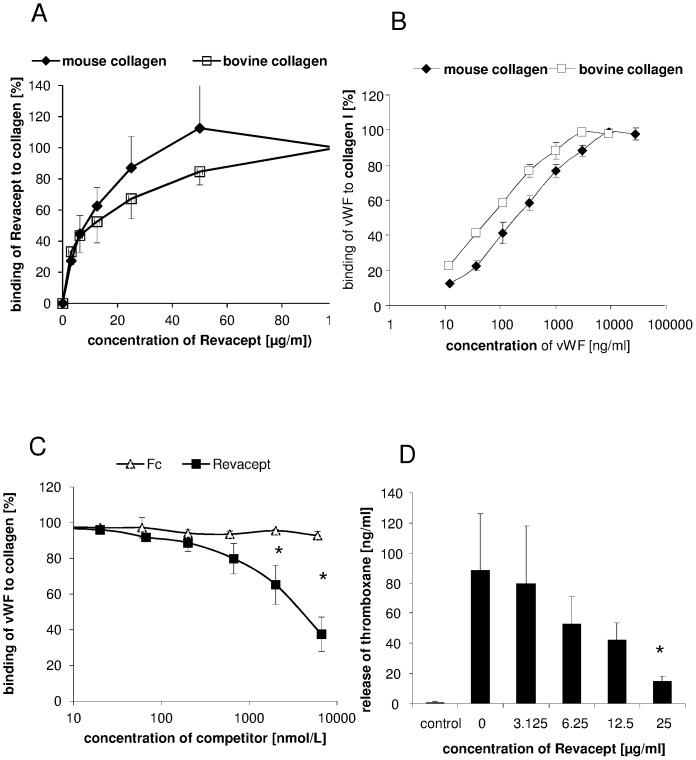
In vitro binding characteristics of Revacept.(A) Concentration-dependent binding of Revacept to immobilized mouse or bovine collagen on microtiter plates. (B) Increasing concentrations of von Willebrand factor (vWF) also bind to immobilized mouse or bovine collagen type I on microtiter plates. (C) Increasing amounts of Revacept lead to a competition with vWF for collagen binding. In contrast, Fc only did not show any inhibitory effect when used in equimolar amounts. Mean ± SEM are given, n = 4 per group, * represents statistical significance of p<0.05. (D) Effect of increasing concentrations of Revacept on release of thromboxane from human platelets. Mean ± SEM are given, n = 8 per group, * represents statistical significance of p<0.05 compared to Revacept 0 µg/ml.